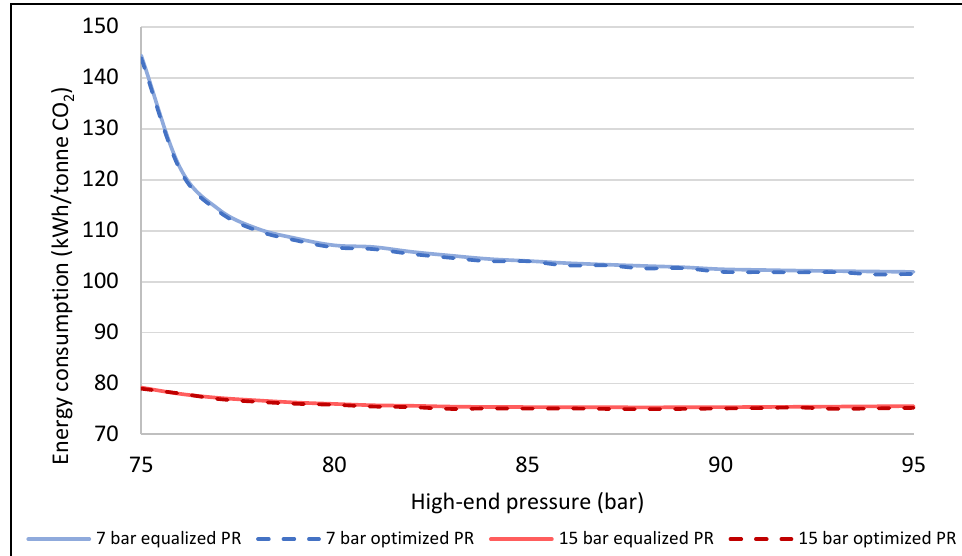
Figure 5. High-end pressure (x-axis) against total compressor power (y-axis) for open-cycle liquefaction. The full lines shows the simulation results with equal pressure ratios and the dashed lines are for optimized pressure ratios. Table 3. Results of the open-cycle liquefaction design with the high-end pressure of 80 bar.